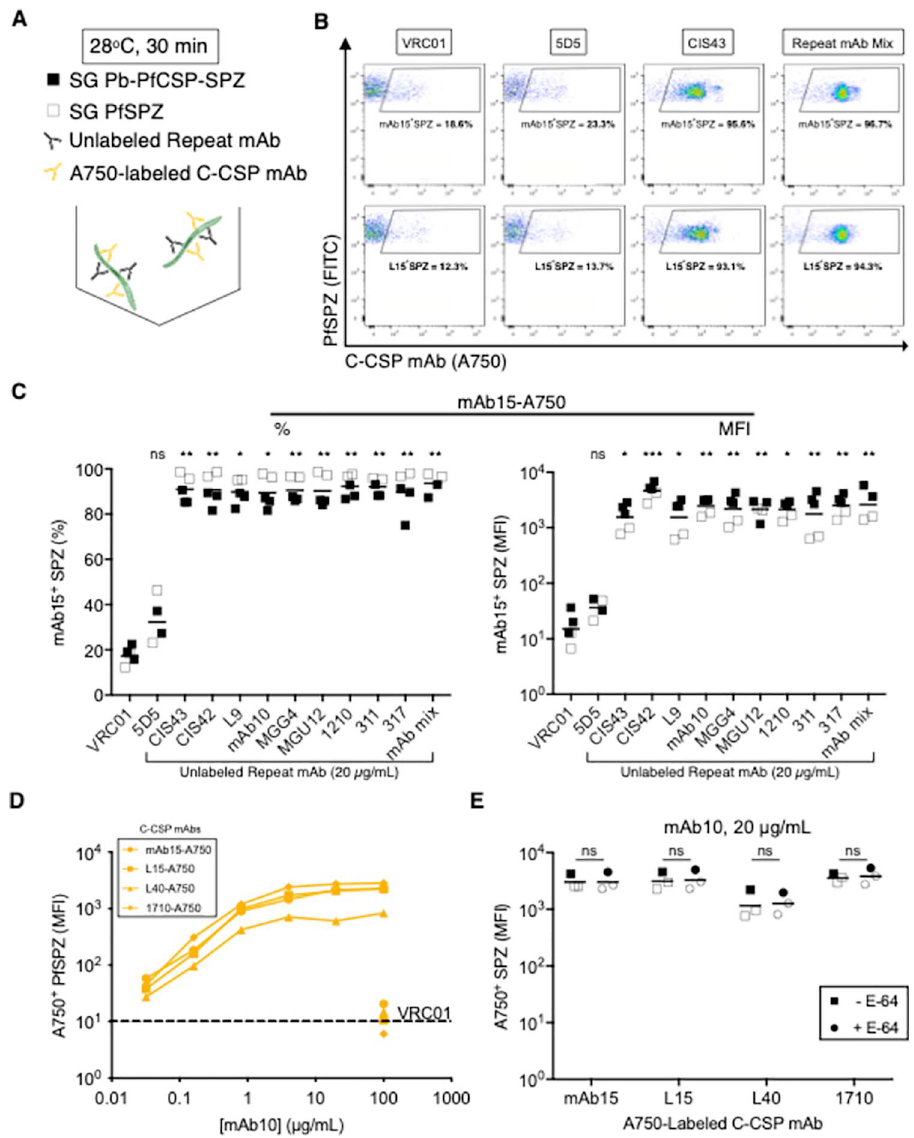
Fig 4. PfCSP repeat mAbs potentiate the SPZ binding of C-CSP mAbs. (A) Experimental schema for measuring the binding of Alexa Fluor 750-labeled mAbs to SG Pb-PfCSP-SPZ or PfSPZ in the presence of unlabeled mAbs. (B) Representative flow cytometry plots depicting 20 μ g/mL mAb15-A750 (top panel) or L15-A750 (bottom panel) binding to SG PfSPZ in the presence of 20 μ g/mL unlabeled VRC01, 5D5, CIS43, and repeat mAb mix (mAb mix, CIS43-317 in C). Percentages of mAb15 + or L15 + SPZ are shown. (C) Percentage and MFI of Pb-PfCSP-SPZ (filled squares) and PfSPZ (open squares) bound by 20 μ g/mL mAb15-A750 when co-incubated with 20 μ g/mL of specified unlabeled mAb. P- values were determined by comparing PfCSP mAbs to VRC01 using the Kruskal-Wallis test. (D) Dose-dependent improvement in PfSPZ binding of four A750-labeled C-CSP mAbs (20 μ g/mL) mediated by increasing concentrations (0.032–100 μ g/mL) of unlabeled NANP-preferring mAb10; 100 μ g/mL unlabeled VRC01 was set as the baseline (dotted line). Data are representative of two independent experiments. (E) Binding of four A750-labeled C-CSP mAbs (20 μ g/mL) to Pb-PfCSP-SPZ (filled symbols) or PfSPZ (open symbols) when co-incubated with unlabeled mAb10 (20 μ g/mL), with or without the protease inhibitor E-64 (squares, no E-64; circles, + E-64). P- values were determined by comparing -E-64 to +E-64 for each C-CSP mAb using a two-way ANOVA with Sidak’s post-hoc correction. (C, E): ��� , p < 0.001; �� , p < 0.01; � , p < 0.05; ns (not significant), p > 0.05.